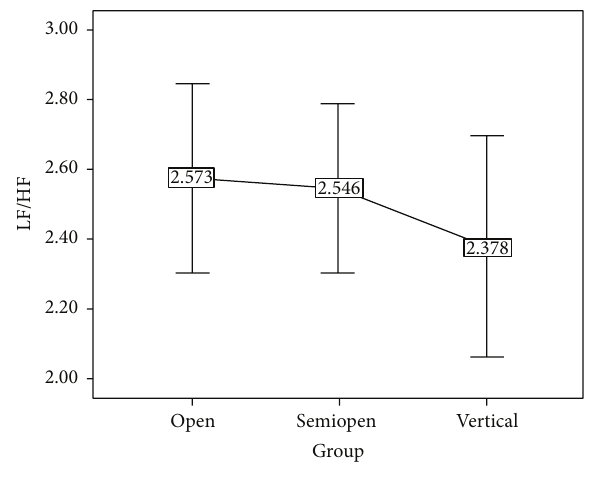
Figure 6: LF/HF’s error bar chart.